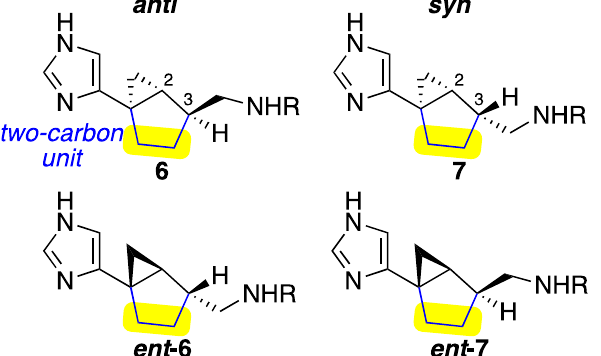
Figure 4. The conformationally restricted histamine analogues 6 and 7 with a bicyclo[3.1.0]hexane backbone, and their enantiomers ent -6 and ent -7 . R indicates a 4-chlorobenzyl group.